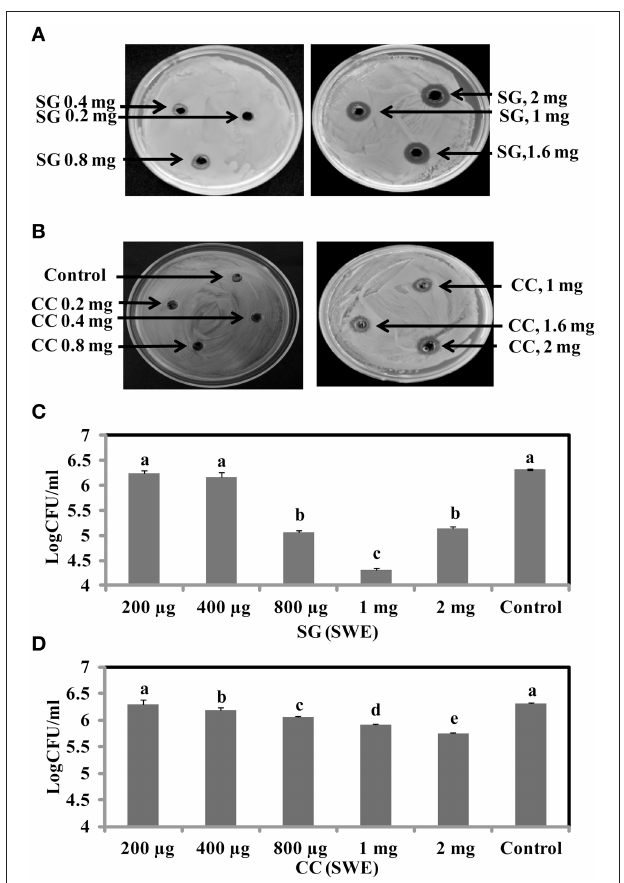
FIGURE 3 | Antimicrobial activities of red seaweeds. Chondrus crispus (CC) and Sarcodiotheca gaudichaudii (SG) were tested at different concentration against S. Enteritidis by agar well diffusion method and liquid culture broth inoculation method. Solid agar showing the zone of growth inhibition at different concentration of (A) SG (B) CC. Liquid culture showing the bacterial colony count at different concentrations of (C) CC extract and (D) SG extract. Values with different superscript letters (Tukey multiple mean comparison) are significantly different (one-way Anova; p < 0.05). Values represent mean ± standard deviation from three independent experiments ( n = 9).